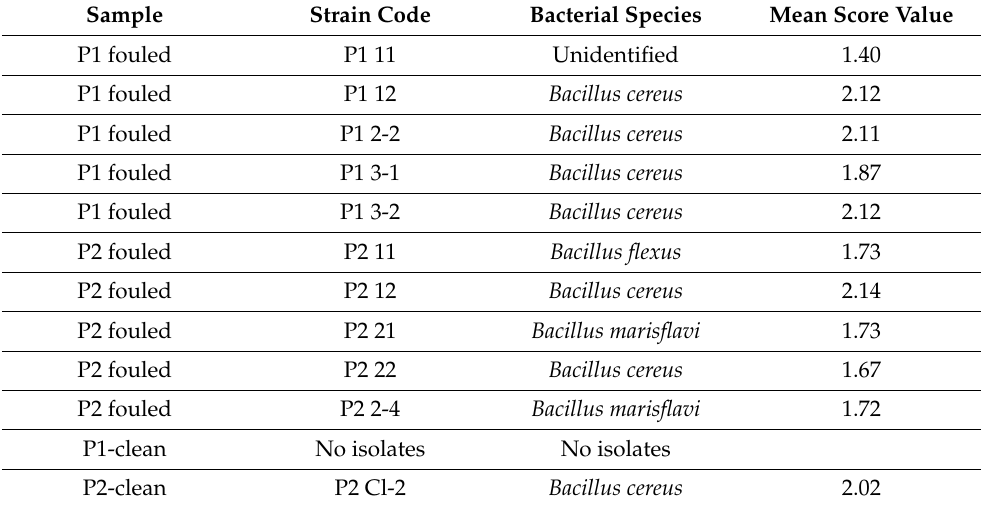
Table 3. Bacterial isolates from fouled and cleaned membranes identified using MALDI-BIOTYPER analysis. The score provided by MALDI-Biotyper analysis: 0–1.69, unreliable identification; 1.70–1.99, probable genes identification; 2.0–2.29, secure genes identification and probable species identification; 2.3–3.0, confident species identification. Sample Strain Code Bacterial Species